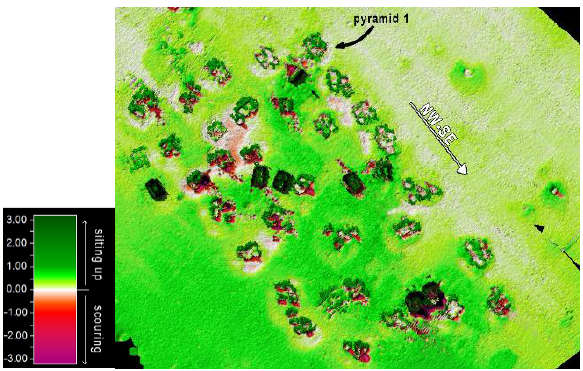
Figure 8. Surface difference between MBES data 2014 and 2002. Pyramid 1 is chosen to draw following corroborating